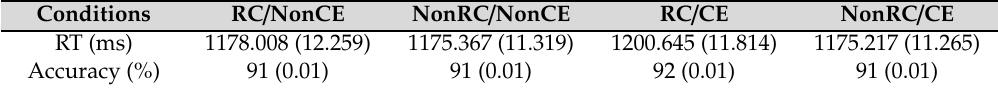
Table 2. The mean RT and mean accuracy for comprehension questions from Experiment